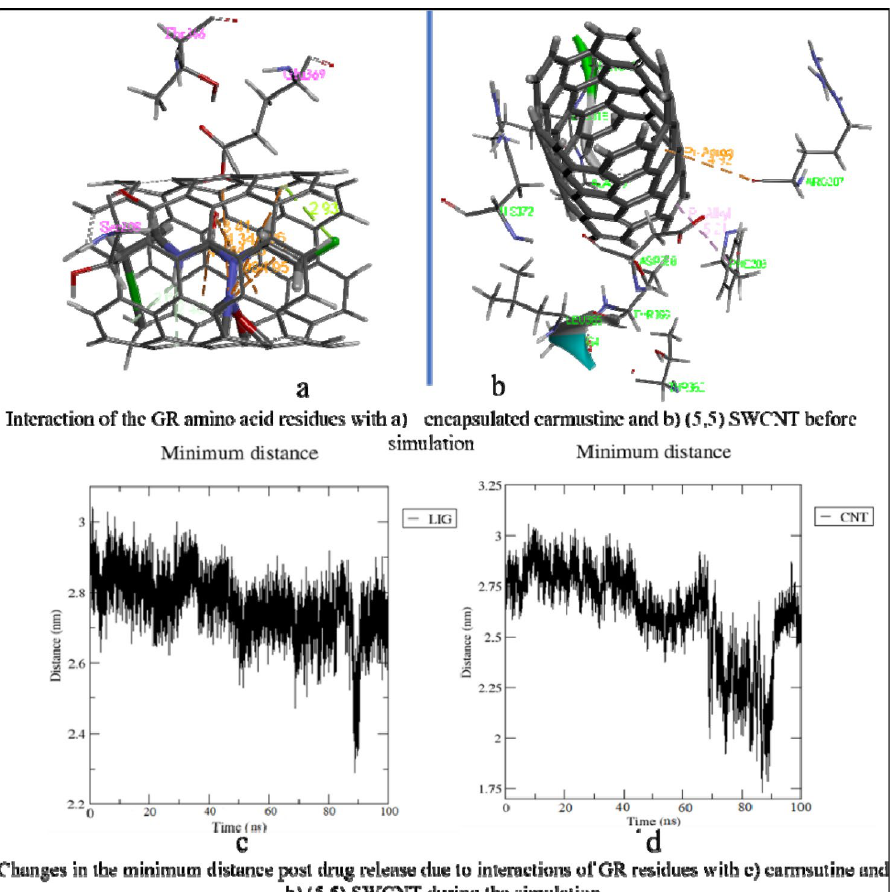
Figure 6. Impact of interactions of GR amino acid with the drug and the